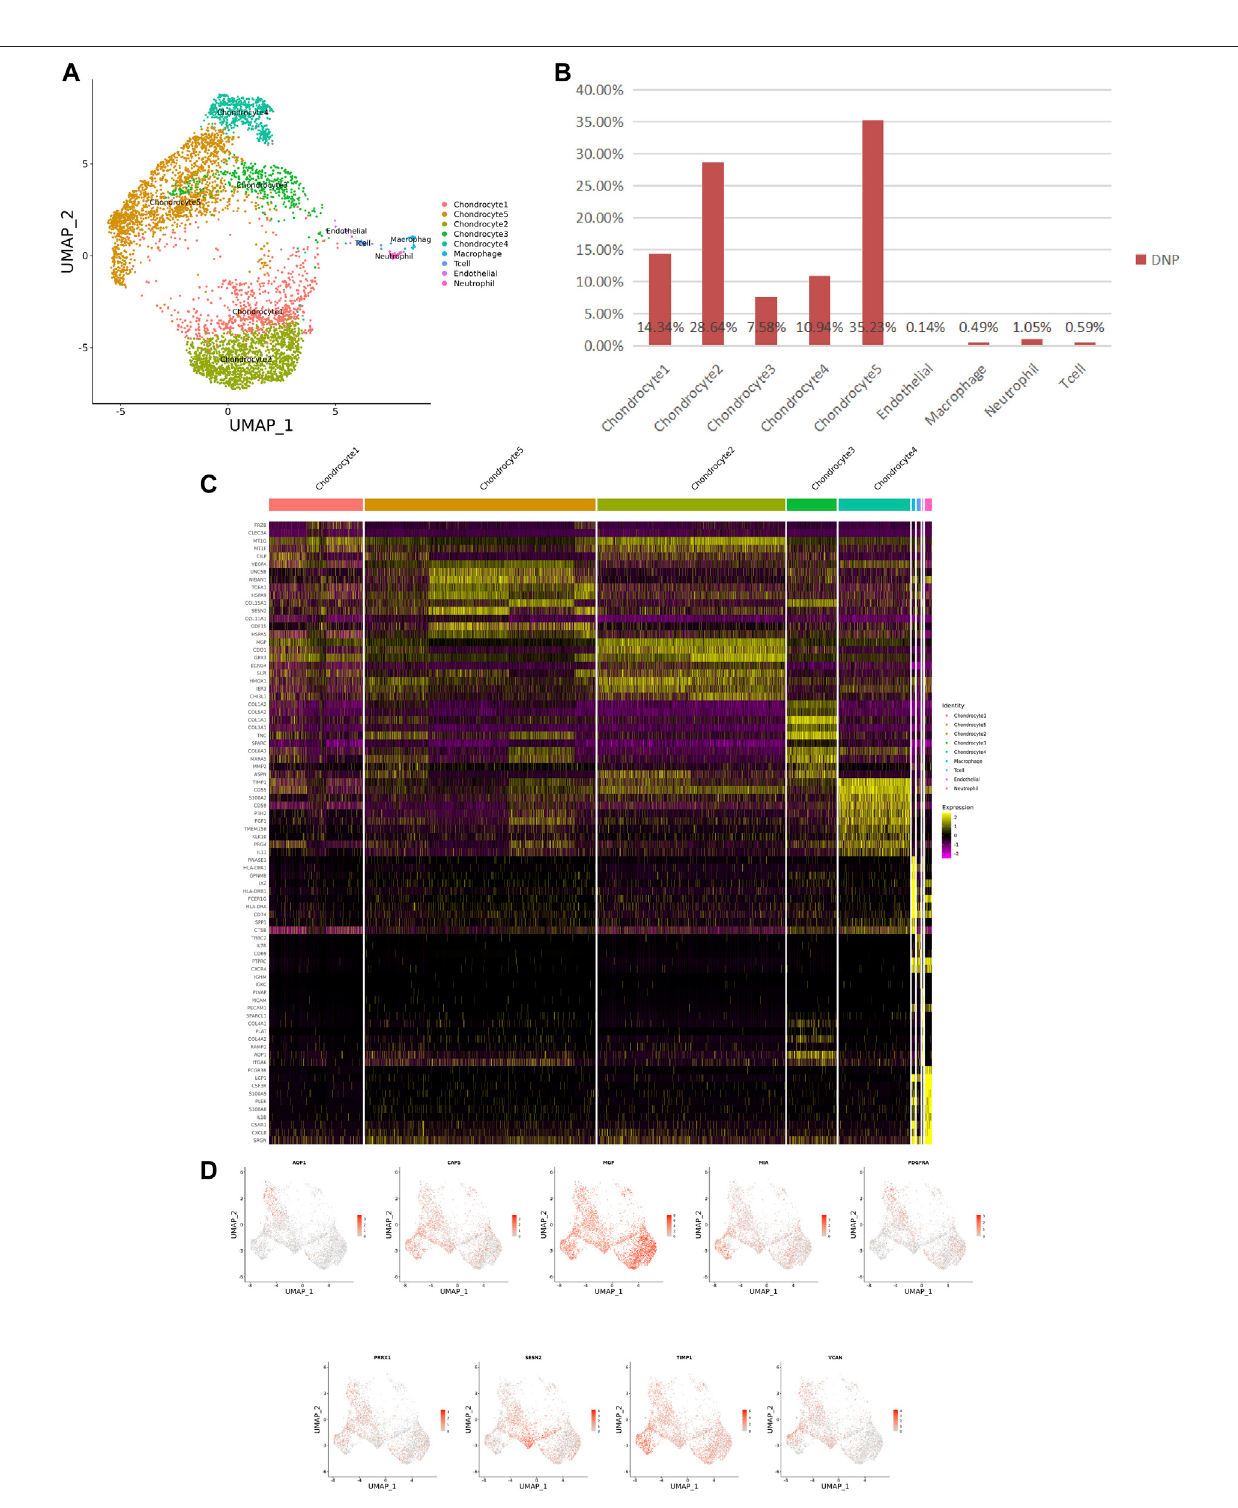
FIGURE 3 | ScRNA-seq cluster analysis of DNP cells. (A) UMAP plots of 5,005 cells, showing the nine major cell types in DNP. (B) Total number of DNP cells with stacked column chart for speci fi ed cell type. (C) Heatmap showing and highlighting differentially expressed genes for each cluster. (D) UMAP plots showing the expression of representative well-known markers for each cell type in chondrocyte (DNP).